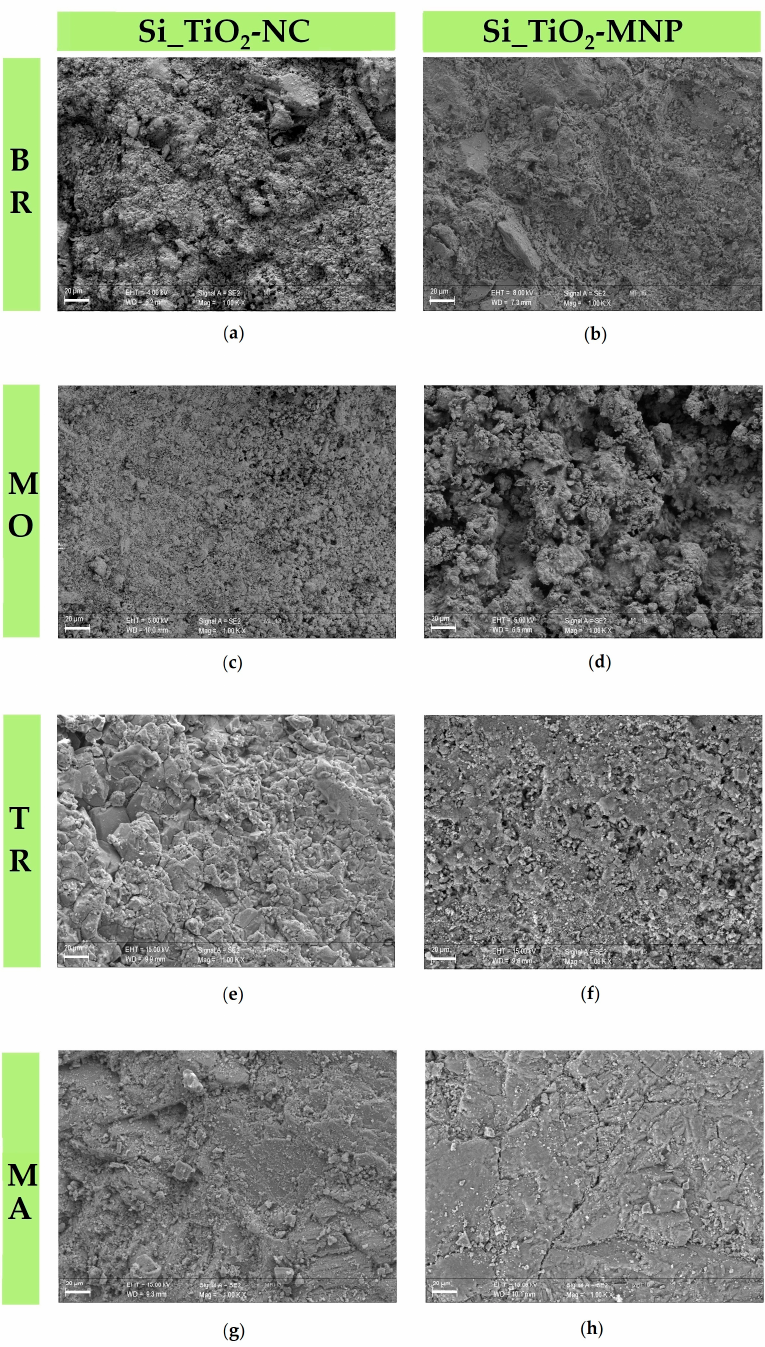
Figure 4. SEM micrographs (1000 × ) of: brick (BR) ( a , b ), mortar (MO) ( c , d ), travertine (TR) ( e , f ) and Carrara marble (MA) ( g , h ). Si_TiO 2 -NC, coating with TiO 2 nanoparticles and loaded silica nanocapsules; Si_TiO 2 -MNP, coating with TiO 2 nanoparticles and loaded silica mesoporous nanoparticles. Treated samples do not show cracks, despite nanoparticle aggregation evidences in some cases.